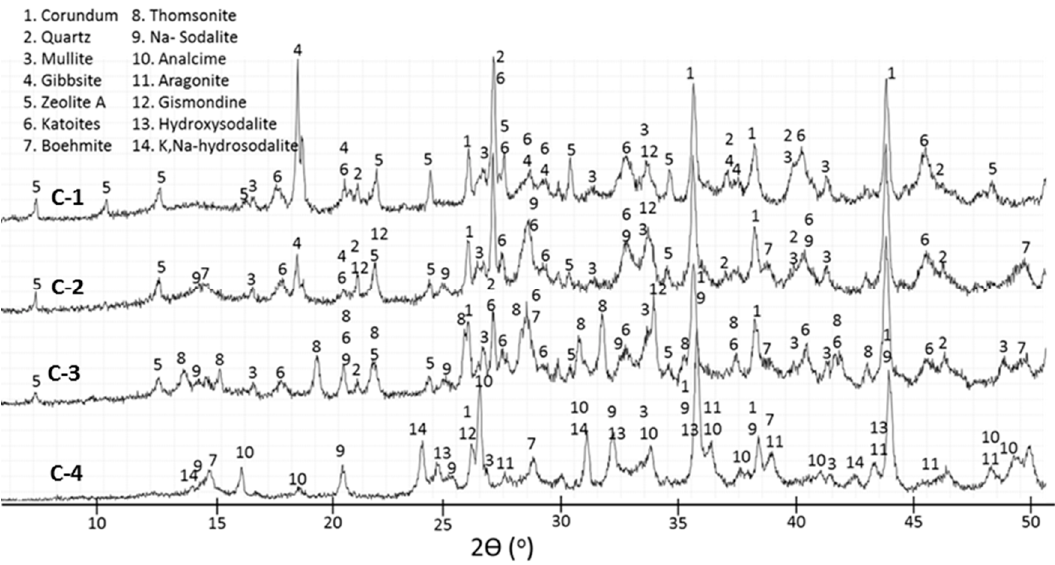
Figure 4. Diffractograms for control TSRC specimens.